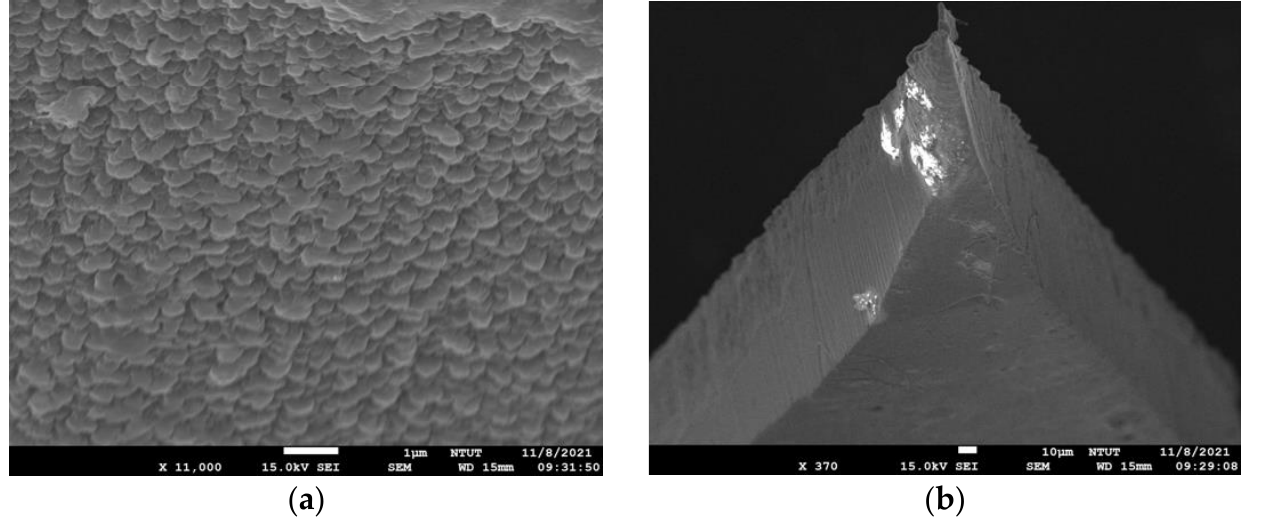
Figure 5. ( a ) The porosity of the PANI polymer layer on the microneedle surface, ( b ) the microneedle sharpening by stamping to ensure that it pierces through the skin.